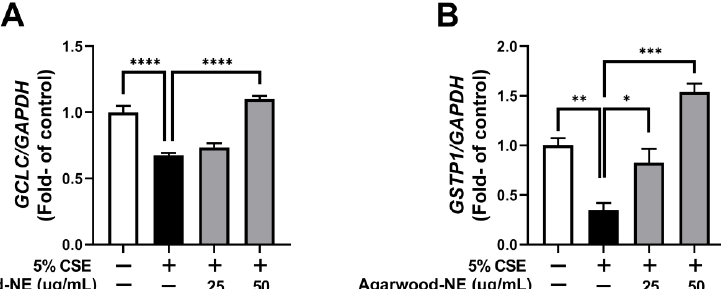
Figure 5. Effect of Agarwood-NE on the CSE-inhibited transcription of antioxidant genes. BCi-NS1.1 cells were pre-incubated for 1 h in the presence of 25 and 50 µg/mL agarwood-NE, followed by exposure to 5% CSE for 24 h. The mRNA levels of GCLC ( A ) and GSTP1 ( B ) were determined via RT-qPCR. Values are expressed as mean ± SEM ( n = 3–4, *: p < 0.05; **: p < 0.01; ***: p < 0.001; ****: p < 0.0001).